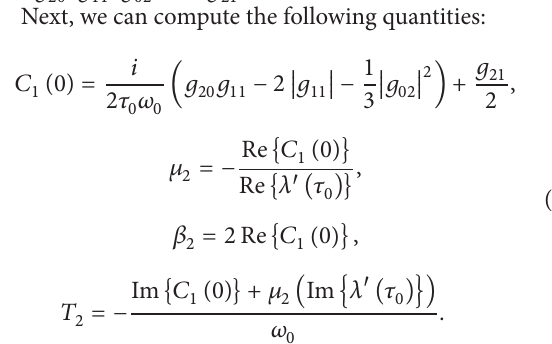
Figure 2: When 𝜏 = 2 , the equilibrium (0.4, 5.4) becomes locally